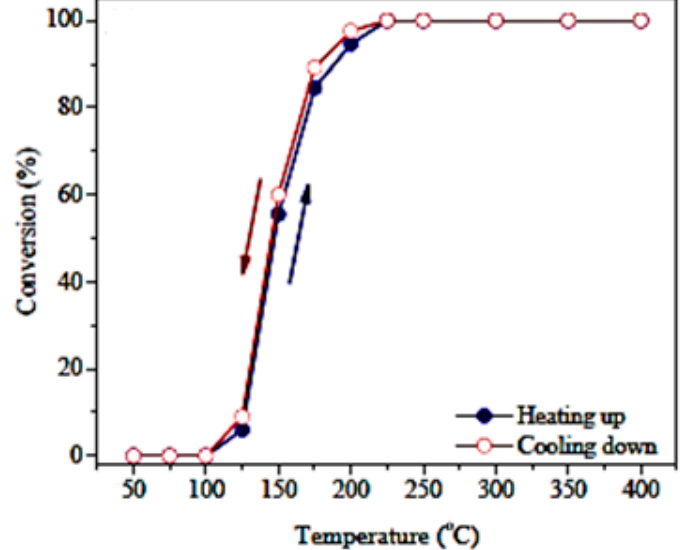
Figure 8. Hysteresis effect during CO oxidation on CuCr 2 O 4 spinel catalyst. Very small hysteresis (almost none) observed [142].